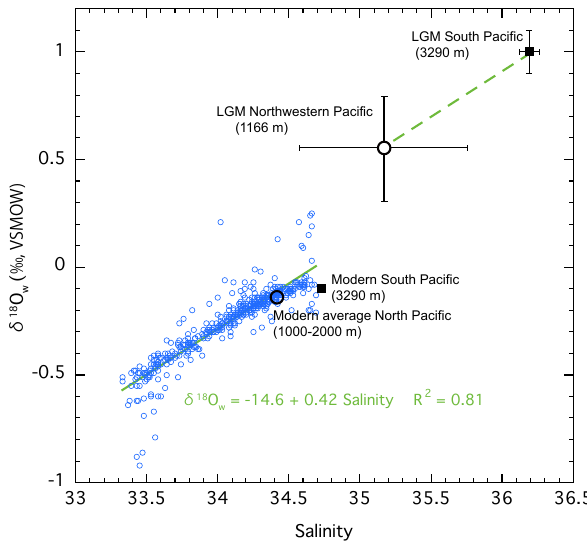
Figure 10. The modern δ 18 O w –salinity relationship at depths greater than 300m is δ 18 O w = 0 . 42 salinity − 14.6 in the area be- tween 120 and 180 ◦ E and 20 and 60 ◦ N in the North Pacific (data from Schmidt et al., 1999). The deep water (3290m water depth) values of salinity and δ 18 O w at present and at the LGM in the South Pacific (Adkins et al., 2002) are represented by black squares. The open circles represent the modern average value in the North Pacific (1000–2000m water depth) and the estimated LGM of the study site in the northwestern